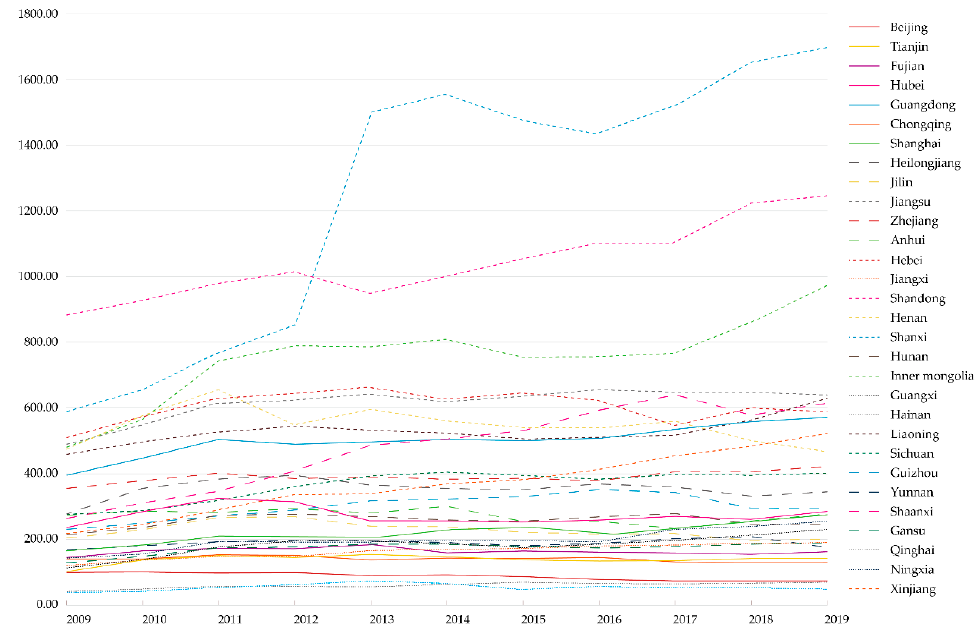
Figure 2. The Carbon Emissions across 30 Provinces in China (2009–2019).